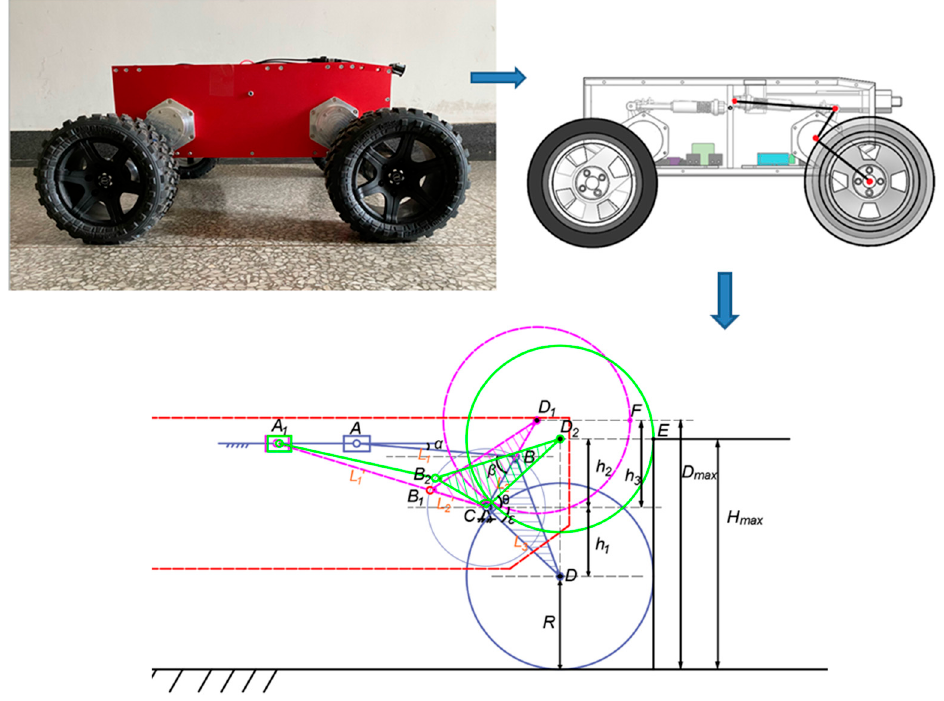
Figure 7. Mathematical model analysis of obstacle crossing height.